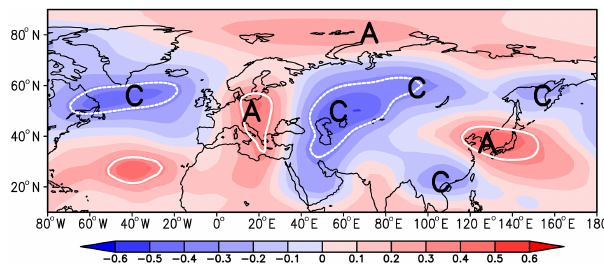
Figure 1. The CC between WHD NCP DY and geopotential height at 500hPa (Z500) in winter from 1980 to 2013. The white curves indicate that the CC exceeded the 95% confidence level. A and C represent anticyclone and cyclone, respectively.